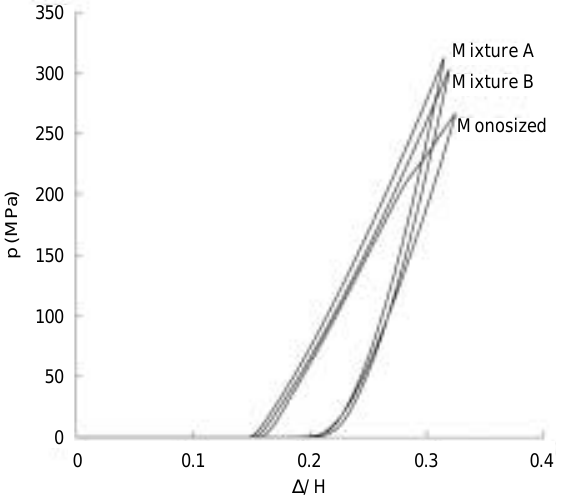
Fig. 4 The global pressure-deformation responses of mixture A, B and monosized particle